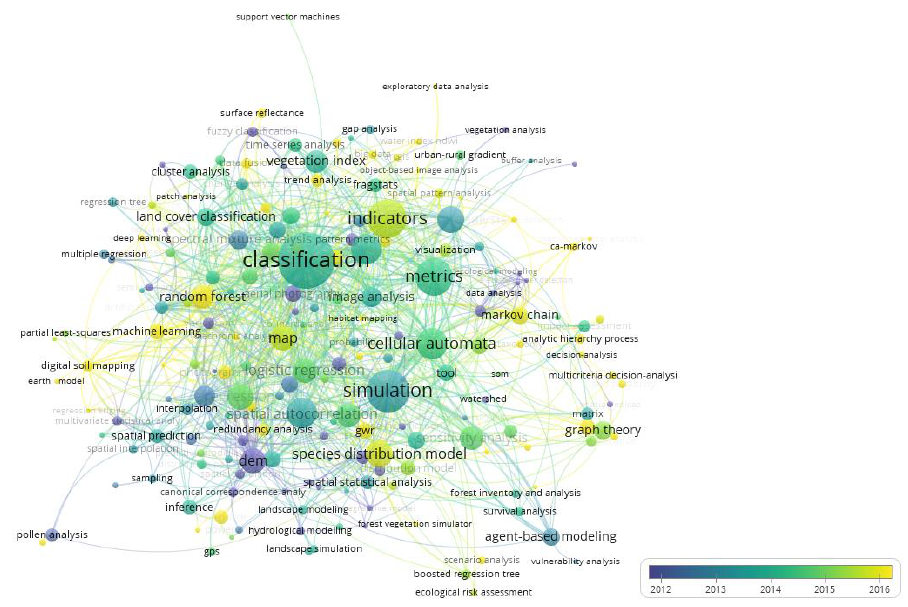
Figure 8. Overlay map for the types of spatial analysis more occurrent in s.a.l.c. research topic. Made with VOSviewer. Table 1. First 100 keywords with the highest number of occurrences.